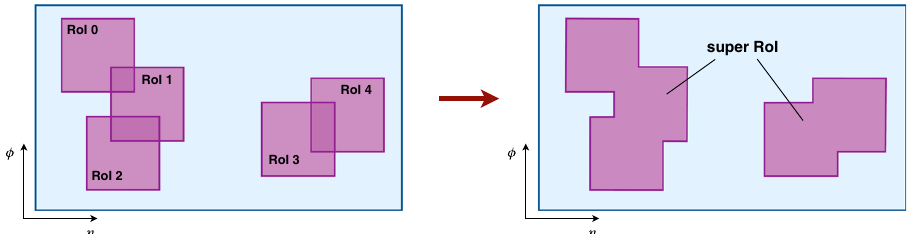
Fig. 8 Schematic illustrating the RoI from the single-stage and two- stage tau lepton trigger tracking, shown in plan view ( x – z plane) along the transverse direction and in perspective view. The z -axis is along the